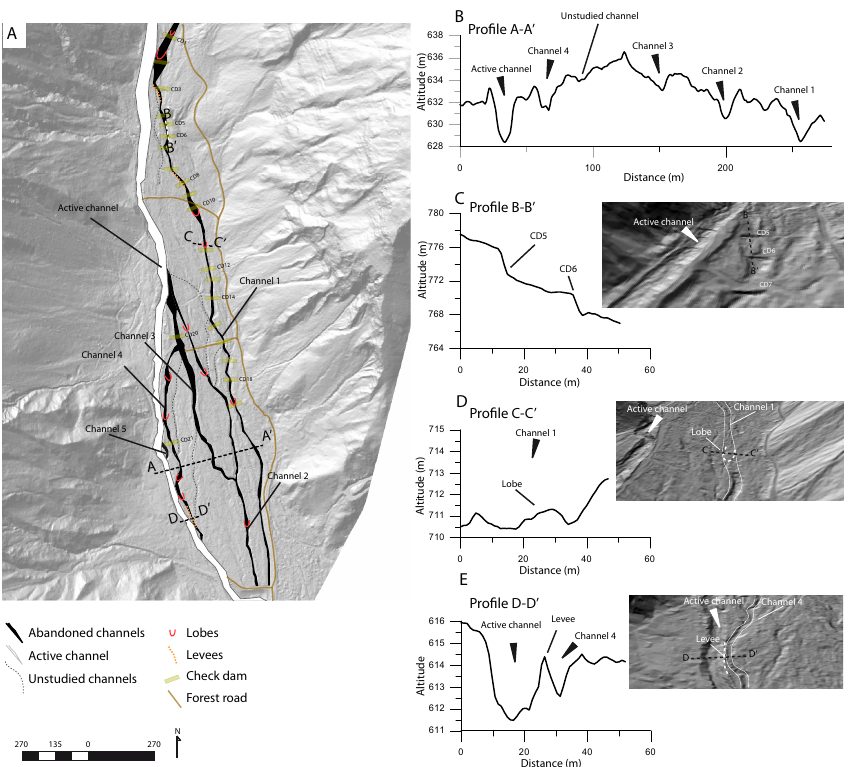
Fig. 3. (A) . Abandoned channels identified on the hillshade map computed using the DEM derived from airborne LiDAR data. (B, C, D, E) Profiles of the Manival torrent at four characteristics location. (A) Cross sections of the five studied abandoned channels. (B) The check dams constructed in the 1950s and 1960s. (C) Section of a depositional lobe. (D) Section of the active